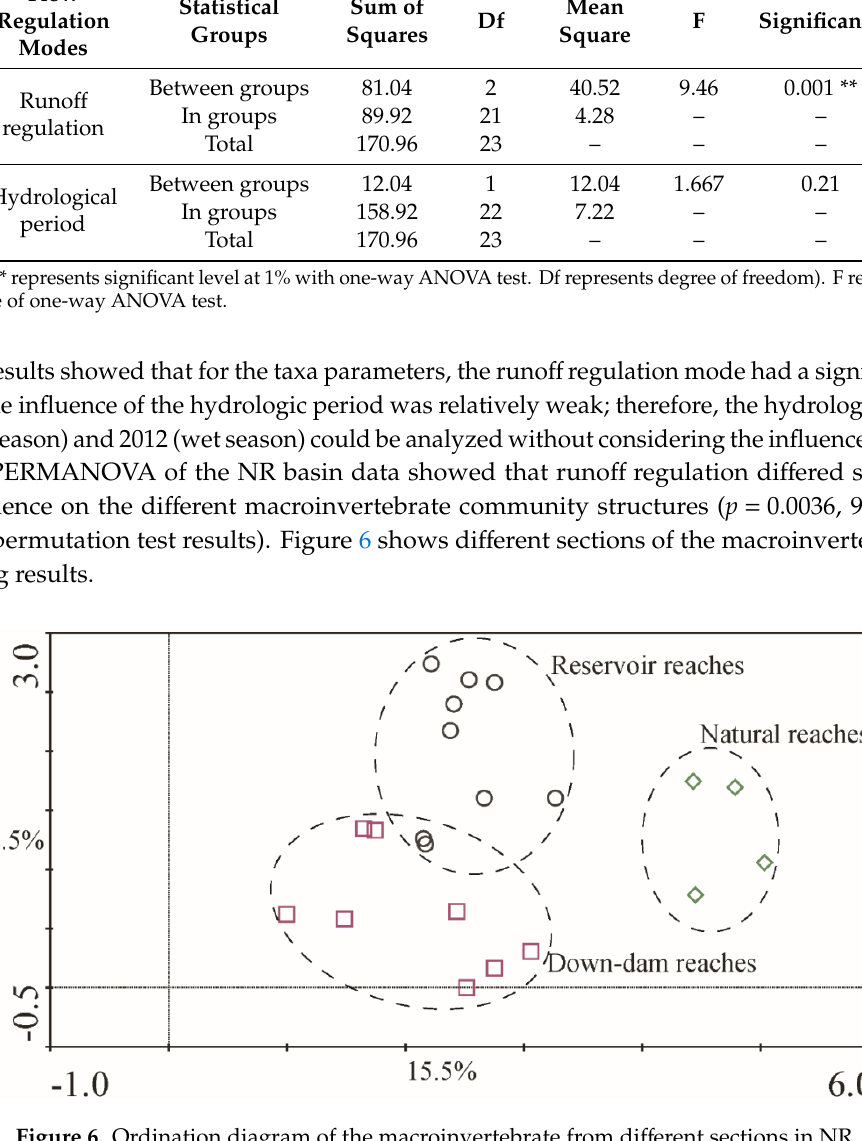
Figure 6. Ordination diagram of the macroinvertebrate from different sections in NR.